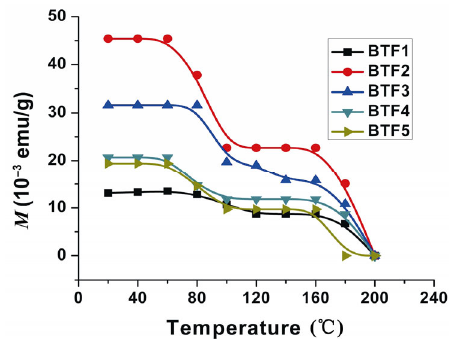
Fig. 9 Dependence of magnetization versus temperature.